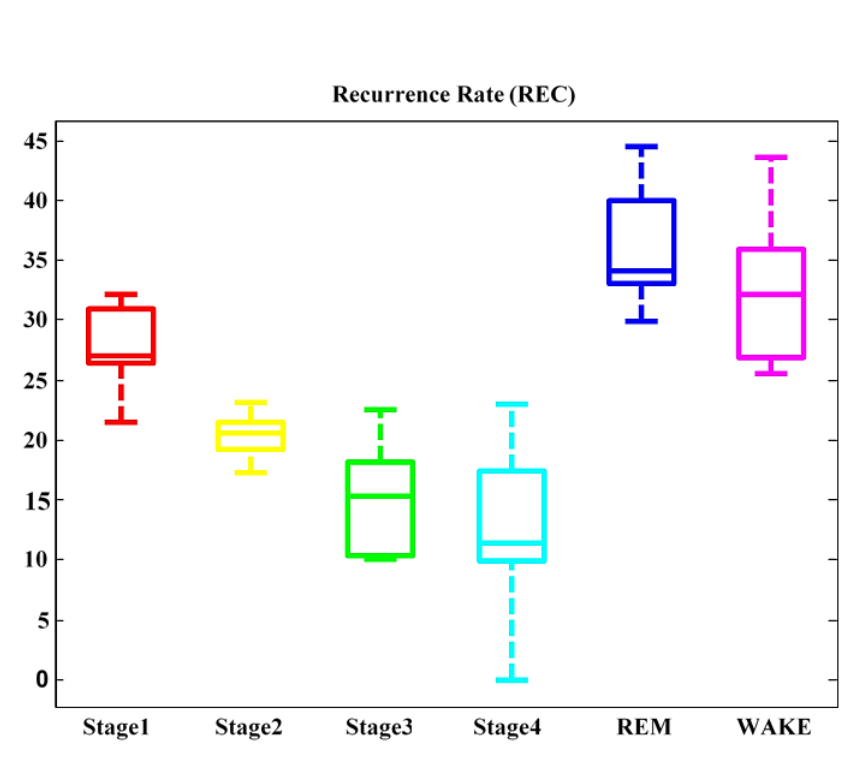
Fig. 7. Compare the sleep stages in Recurrence Rate